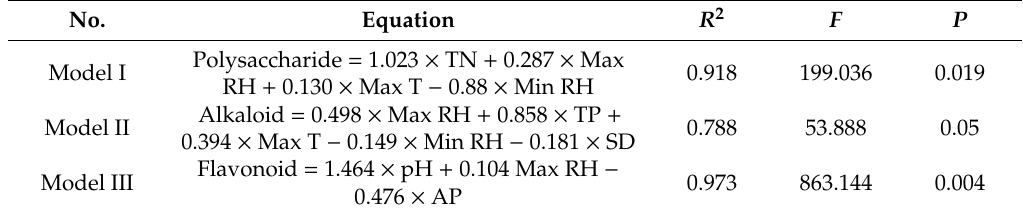
Table 4. Stepwise multiple linear regression (SMLR) analysis of ecological factors influencing the main medicinal components in D. o ff ficinale